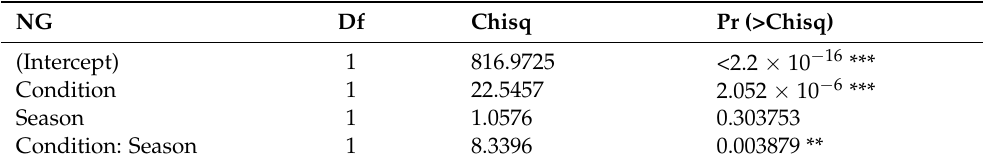
Figure 5. The number of glomerospores recovered in aquatic/terrestrial and rainy/dry season conditions. Boxplots with different letters differ statistically by ANOVA ( p < 0.05). Table 3. Generalized Linear Models (GLM) exploring differences in number of glomerospores (NG) in relation to condition (aquatic/terrestrial), seasonality (rainy/dry) and interactions (condi-